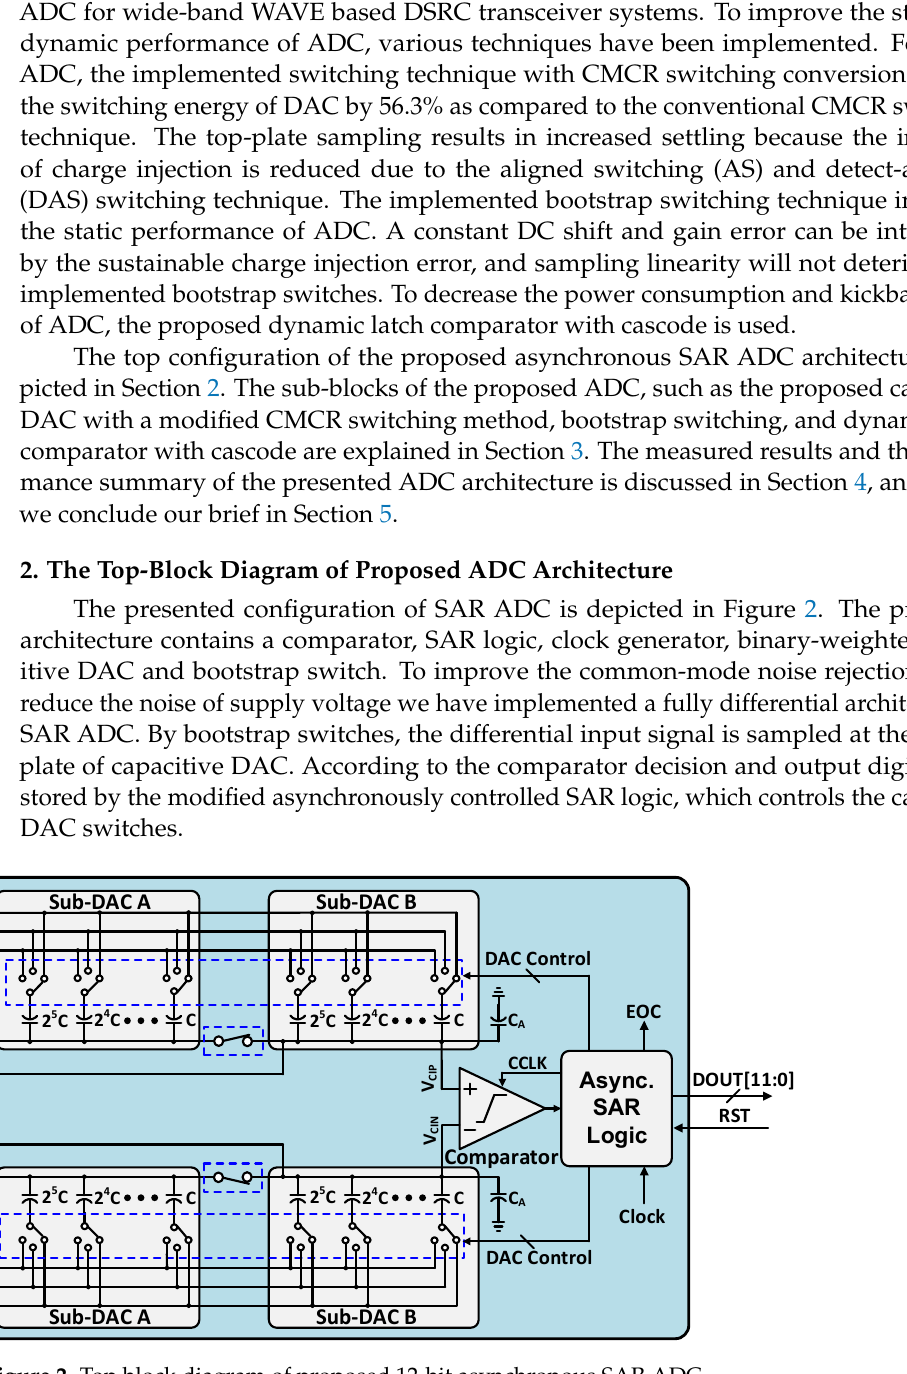
Figure 2. Top block diagram of proposed 12-bit asynchronous SAR ADC.